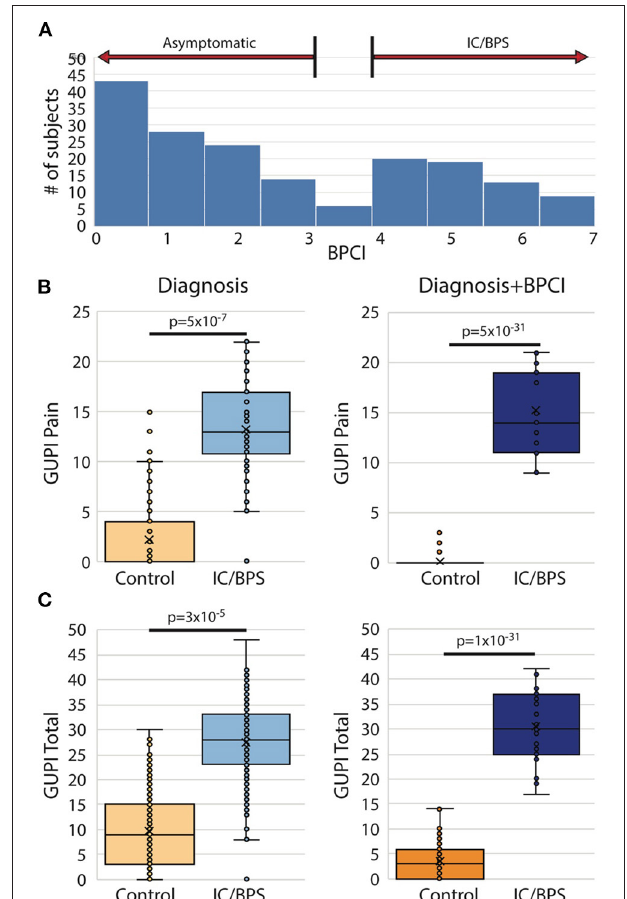
FIGURE 1 | Bladder pain composite index (BPCI) defines more homogeneous IC/BPS and control populations. (A) BPCI score distribution for 521 subjects with and without urinary symptoms recruited as possible participants revealed a clear division between patients with and without bladder pain and was used to define our study populations for this proposal. (B,C) Use of clinical diagnosis of IC/BPS results in substantial symptomatic overlap in (B) pain severity (fGUPI Pain domain) and (C) overall urinary symptoms (fGUPI total score) with subjects identified as controls (left), while separation based on a BPCI > 4 provides more homogeneous, distinct populations